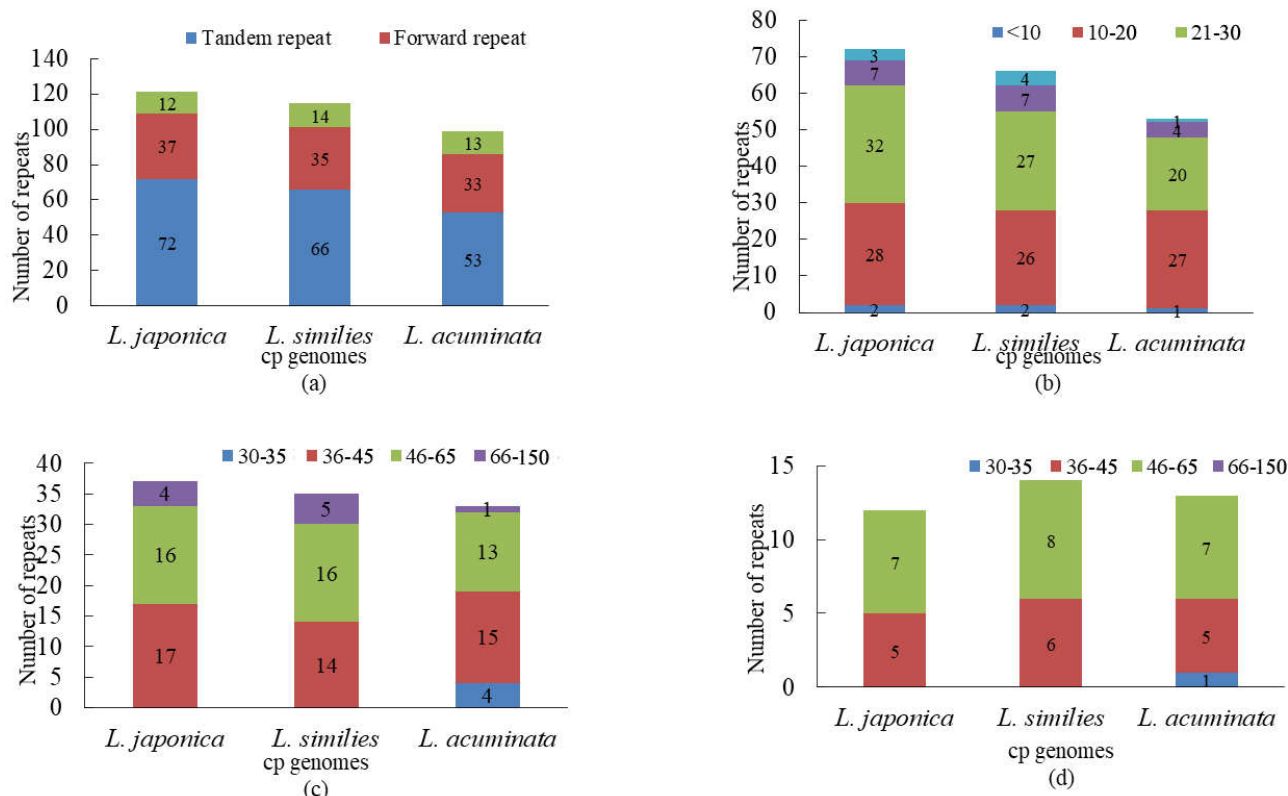
Figure 2. Repeat sequences analysis of three cp genomes. ( a ) Repeat types in three cp genomes; ( b ) tandem repeats in three cp genomes; ( c ) forward repeats in three cp genomes; ( d ) palindromic repeats in three cp genomes. In ( a ), different colors show different repeat types; in ( b – d ), different colors show different lengths. The ordinate represents the number of repeats; the abscissa represents three cp genomes.